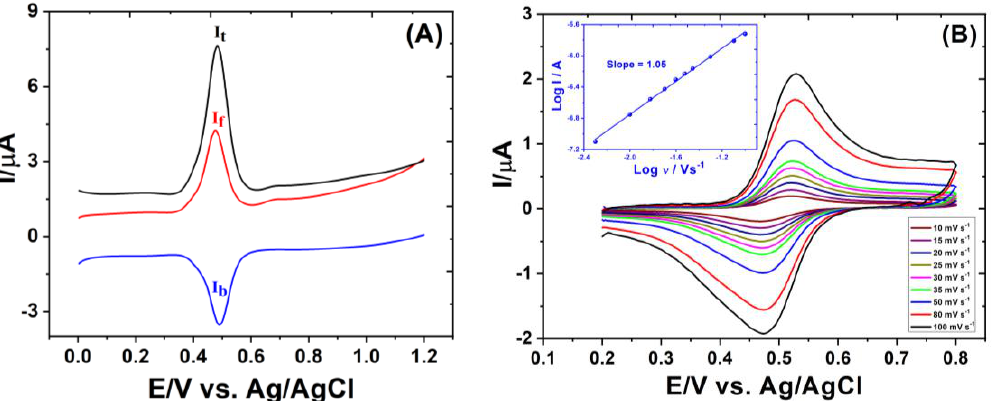
Figure 2. Voltammetry of 40 ppm PAs on GCE in B-R buffer (pH 1.80) using ( A ) SWV at frequency 10 Hz, pulse amplitude 25 mV, pulse width 1 mV (I t total current, I f forward current, I b backward current) ( B ) CVs at different scan rates (5 – 100 mV s −1 ), Inset: Log i p vs. Log ν of the anodic wave.